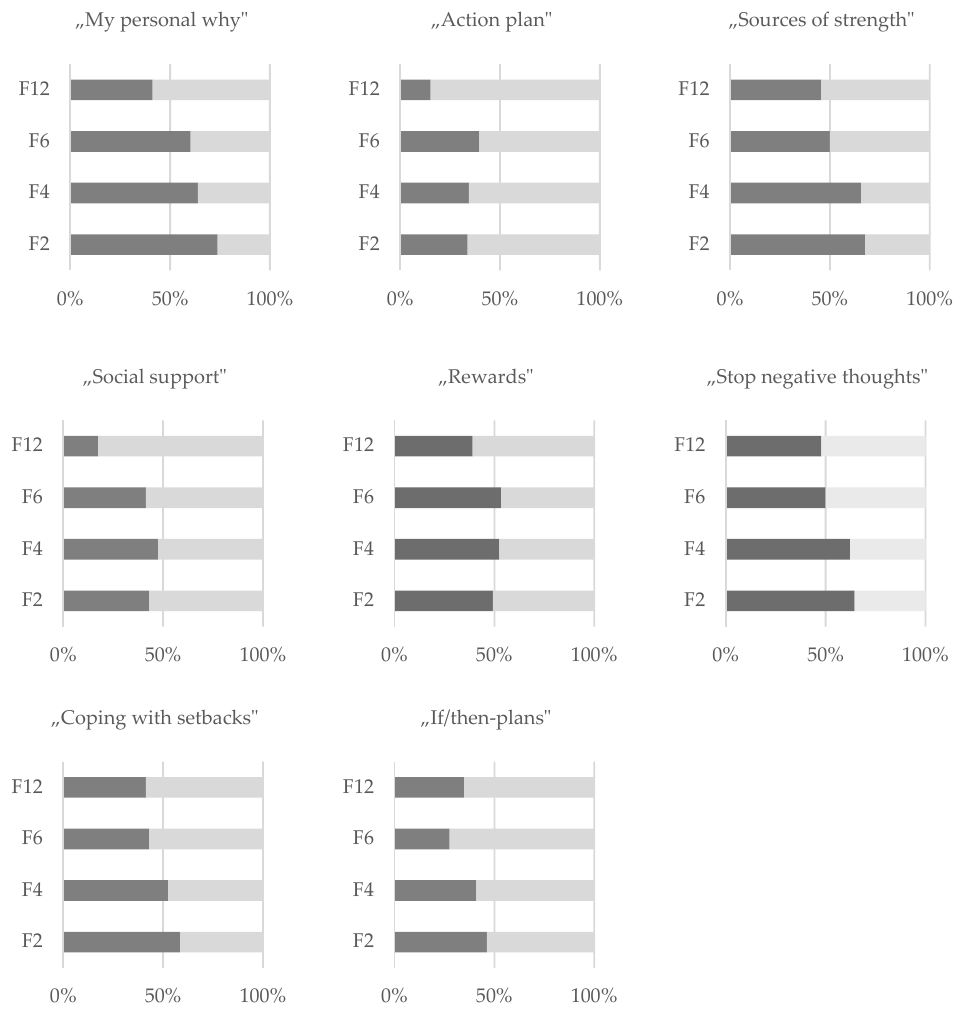
Figure 4. Sustained use of practical tips contained in videos of the app. Notes: Presentation in numbers of participants. Abbreviations: F2, two months after the intervention; F4, four months after the intervention; F6, six months after the in- tervention; F12, twelve months after the intervention.